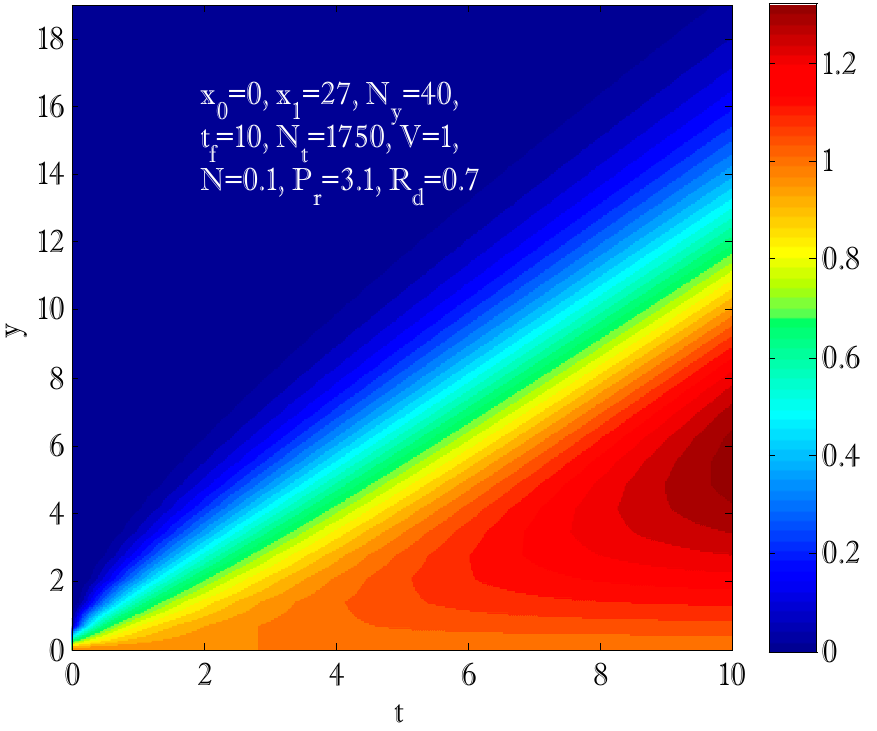
Figure 7. Contour plot for velocity using V = 1.